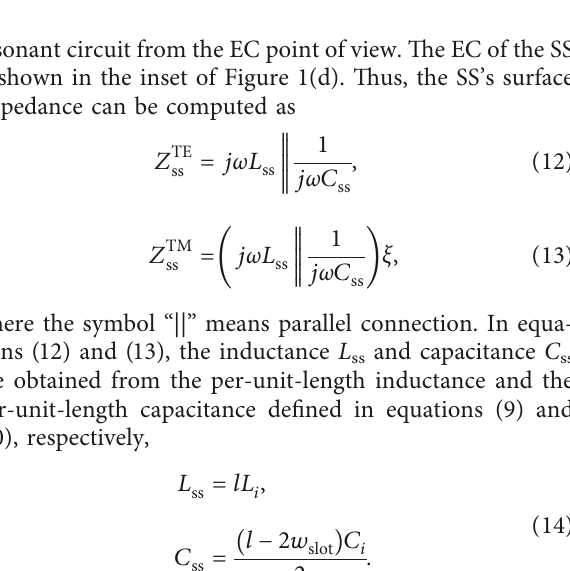
Figure 1: The four FSS structures as the building blocks of multilayer FSSs. (a) Square grids (SGs). (b) Square patches (SPs). (c) Square loops (SLs). (d) Square slots (SSs). Metallic parts are colored in